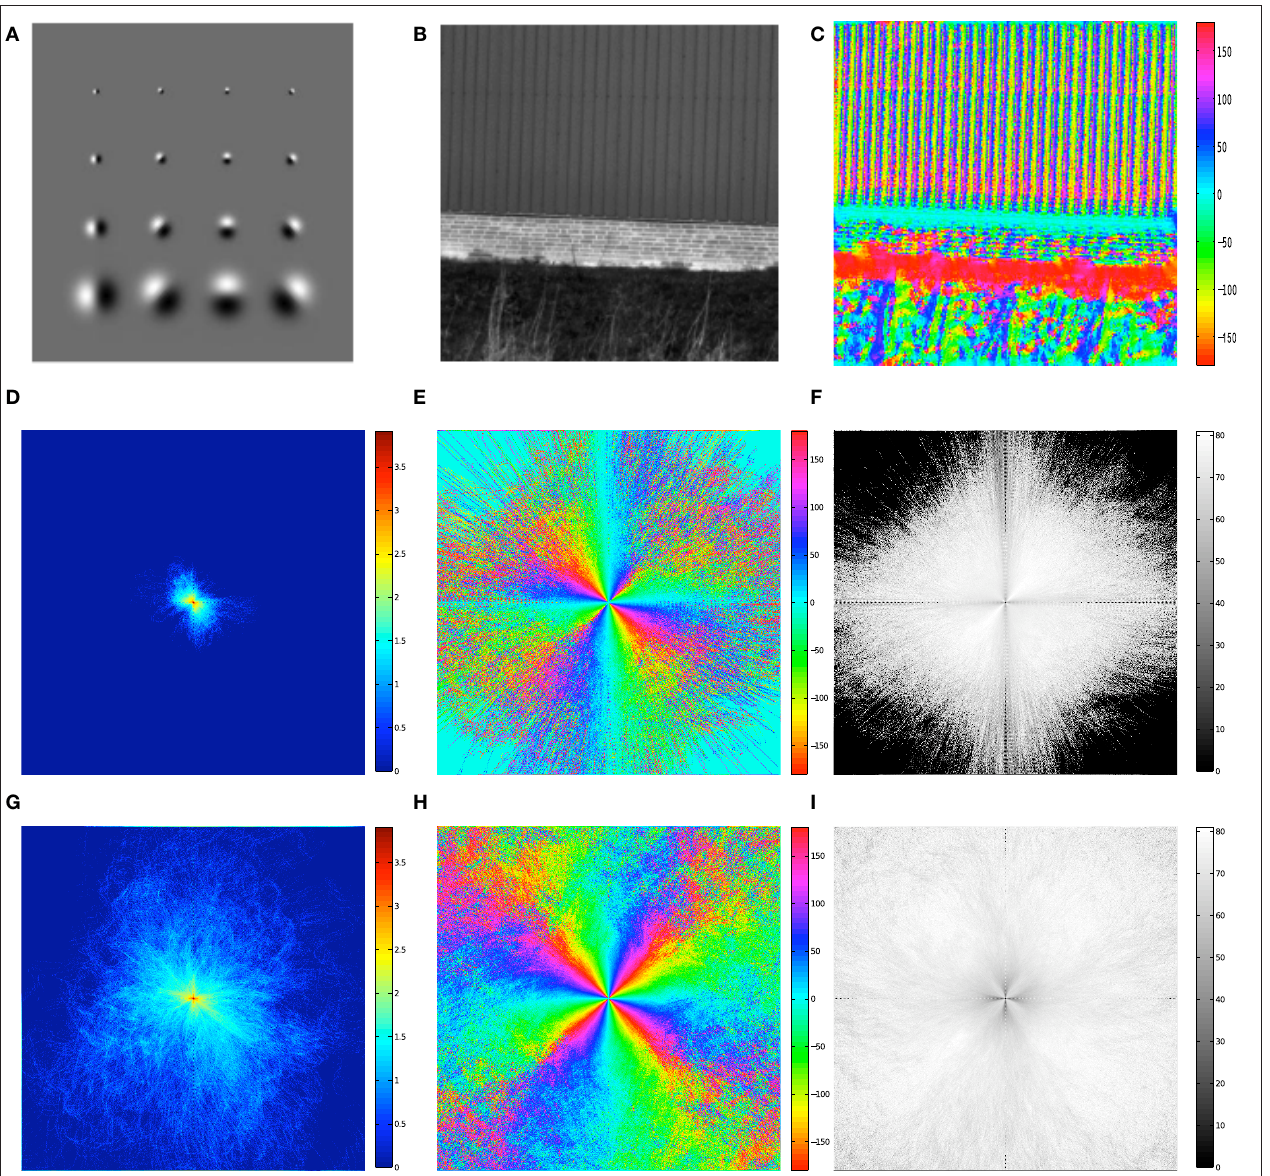
show an increased likelihood that adjoining edges occur along the orientation of the contour. The colorbar shows the relative frequency in log units. Relative orientation data shown in (e) for natural images and (H) for contoured stimuli show an increased likelihood that adjoining edges are likely to have an orientation that is consistent with smooth curvature (colorbar shows relative orientation). Lastly, orientation circular standard deviation (in degrees, shown by the colorbar) in (F) for natural images and (i) for contoured stimuli show that orientation variability increases away from the axis of a straight